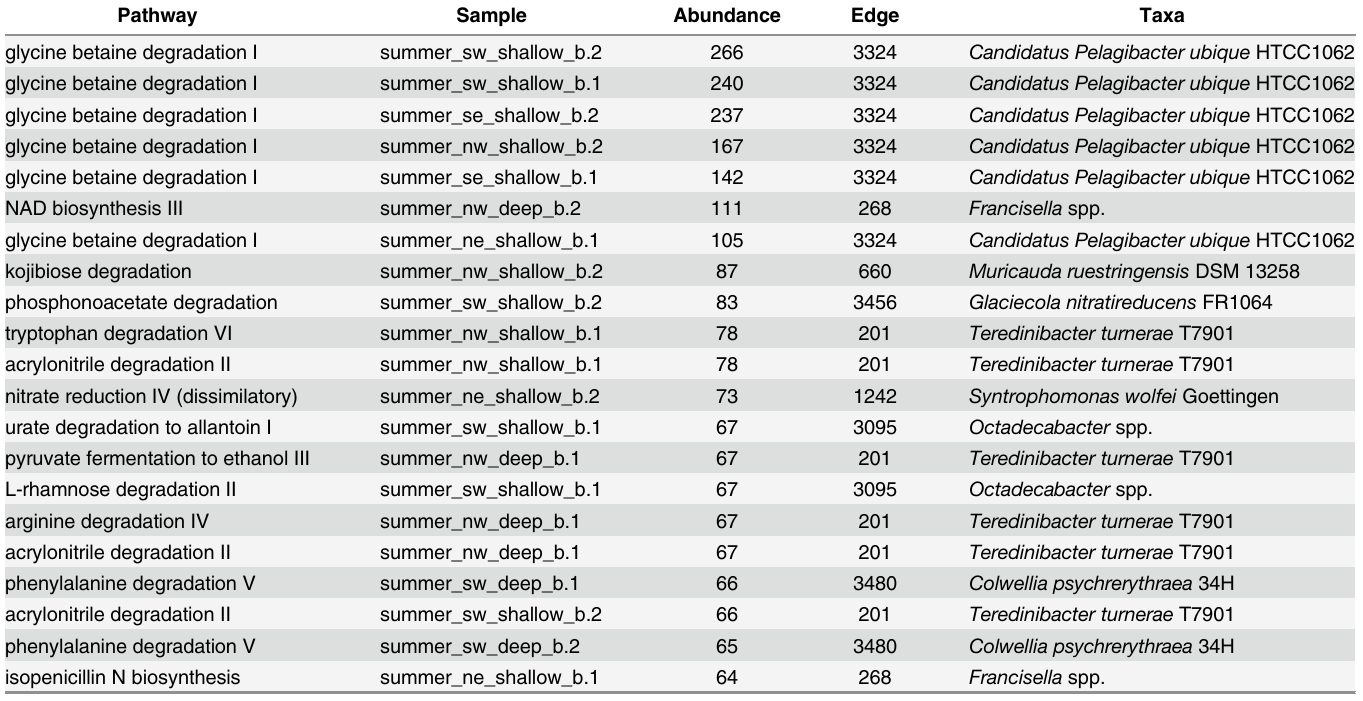
Table 1. Pathways with abundance greater than 60 appearing in only a single